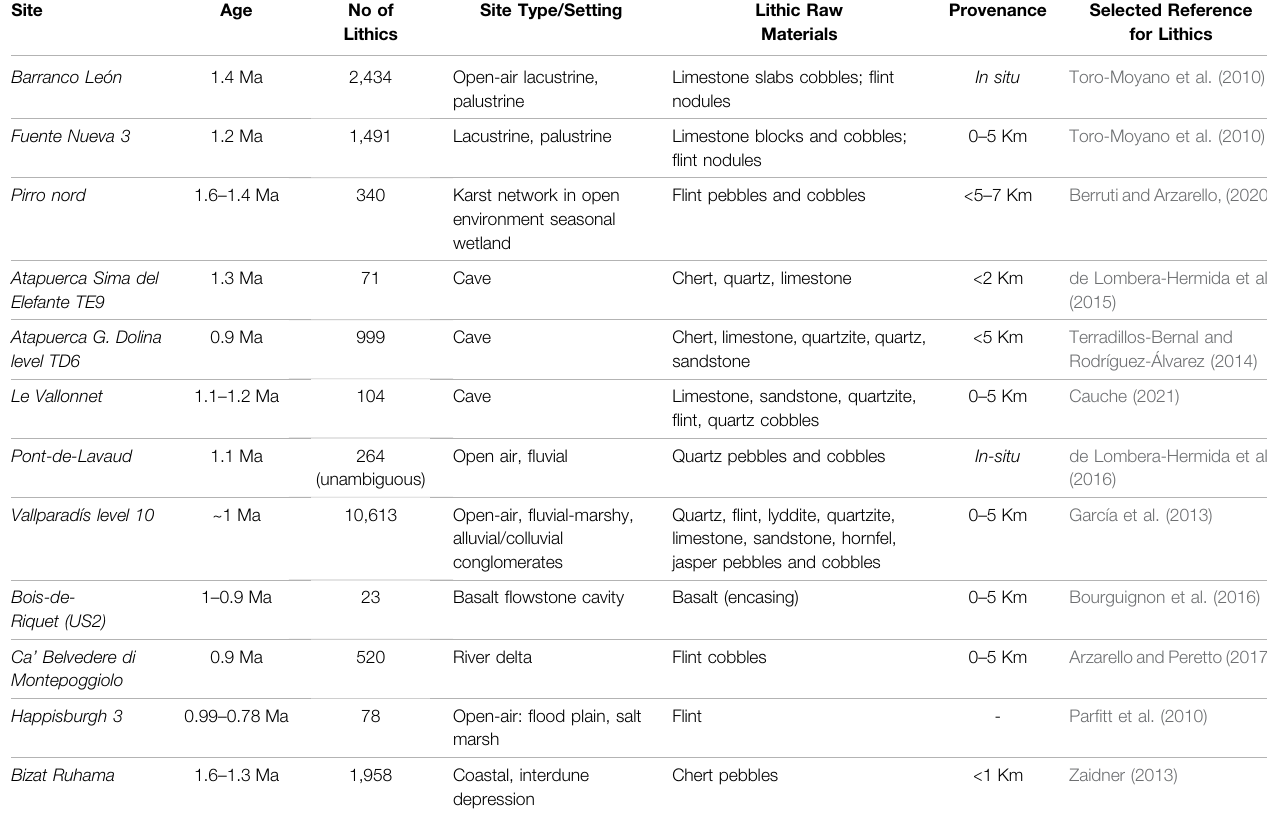
TABLE 5 | Site types and main lithic raw material ’ s features at selected Eurasian Oldowan sites (in this table a single publication from which the information was obtained is cited for each